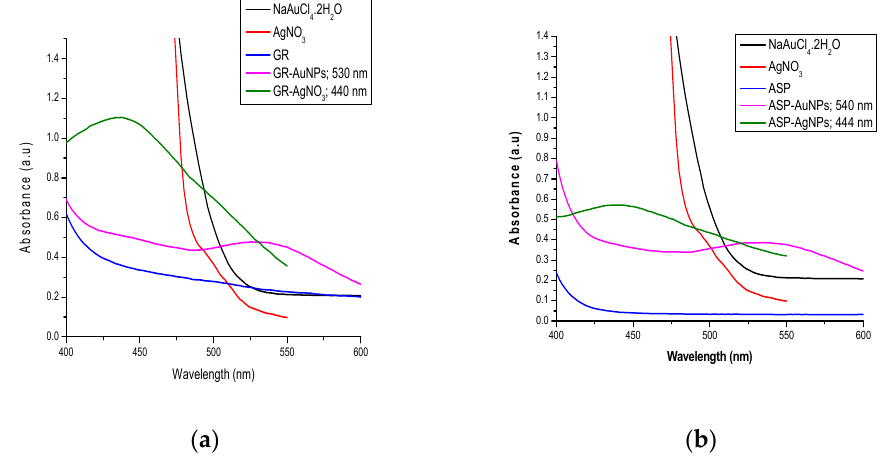
Figure 2. ( a ) UV–Vis spectra for the synthesised green Rooibos (GR) gold and silver nanoparticles. ( b ) UV–Vis spectra for the synthesised aspalathin (ASP) gold and silver nanoparticles.